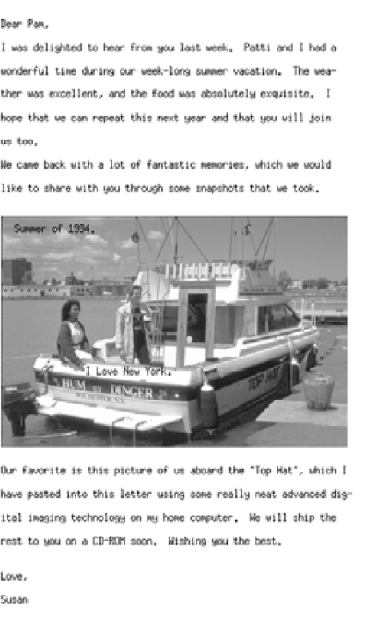
Figure 1: Left: original cmpnd1 image; right: classification